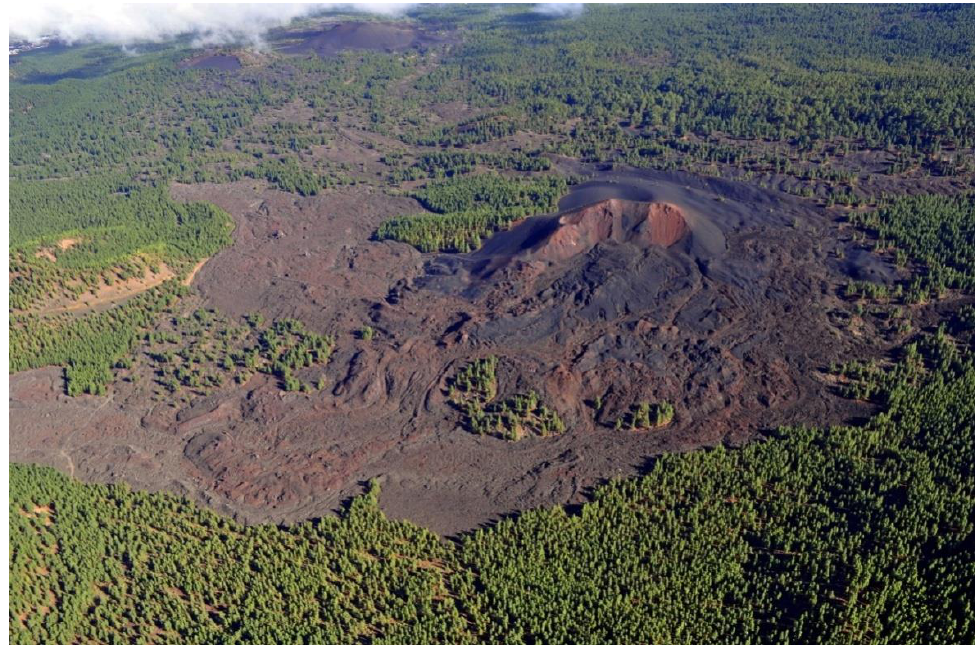
Figure 4. Chinyero volcano. Source: http://www.fotosaereasdecanarias.com.